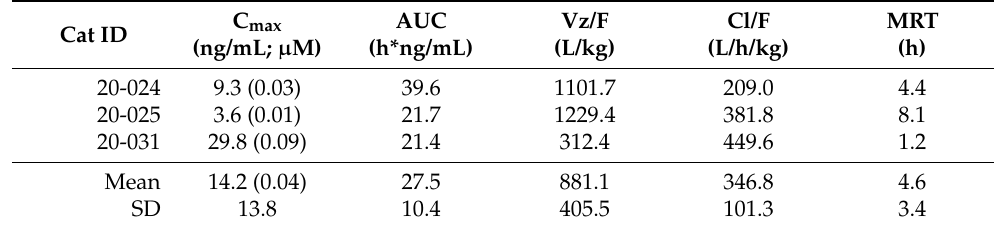
Table 1. Pharmacokinetic parameters for parent drug (MPV) from noncompartmental analysis following a 10 mg/kg oral dose of molnupiravir in three cats.